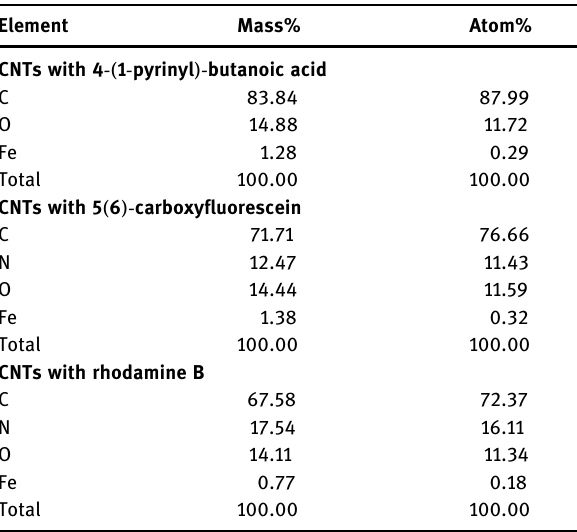
using this imaging method. Early detection of cancer and the simultaneous use of targeted therapy with the ability to monitor treatment e ffi cacy is a signi fi cant step towards improving treatment e ffi ciency.